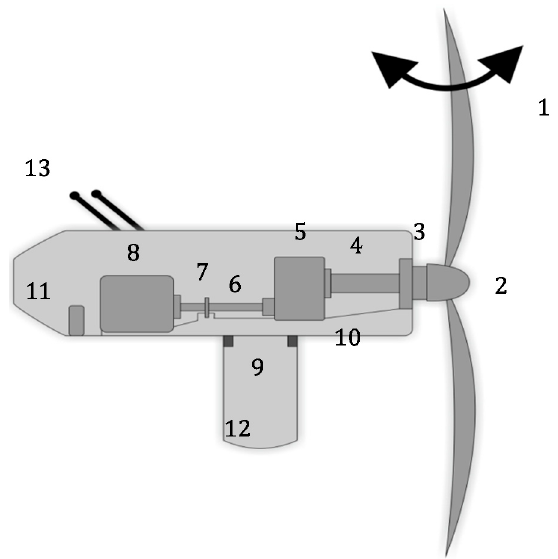
Figure 2. Main components of the most installed WT where: 1—pitch system; 2—hub; 3—main bearing; 4—low speed shaft; 5—gearbox; 6—high speed shaft; 7—brake system; 8—generator; 9—yaw system; 10—bedplate; 11—converter; 12—tower; 13—meteorological unit. (Adapted from [10]).